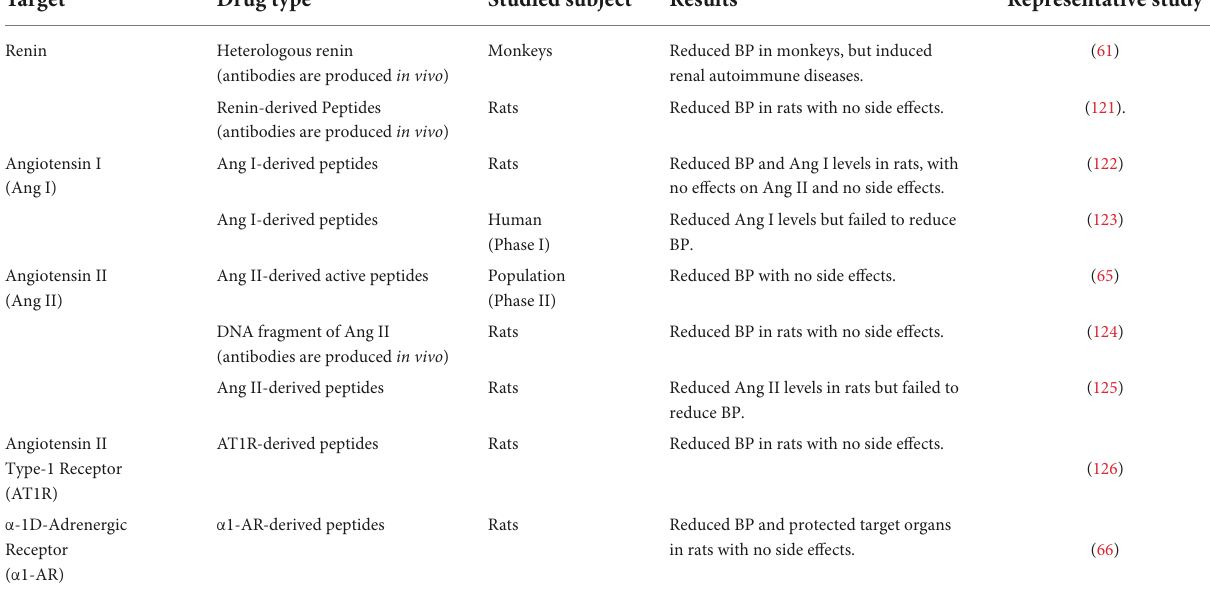
TABLE 1 Hypertension